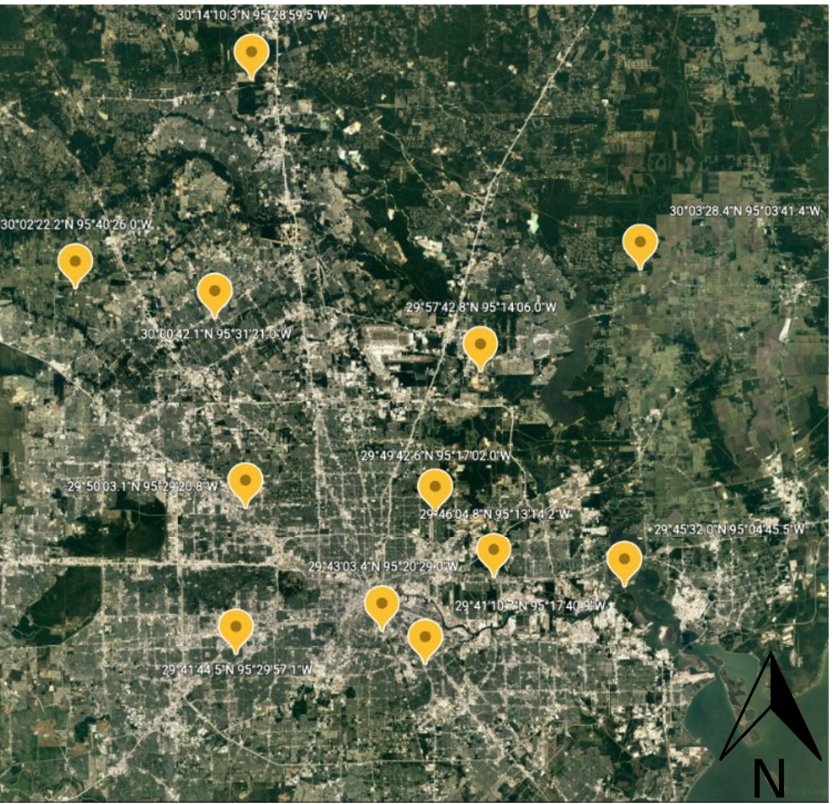
Figure 1. Map of the Houston area and weather stations.